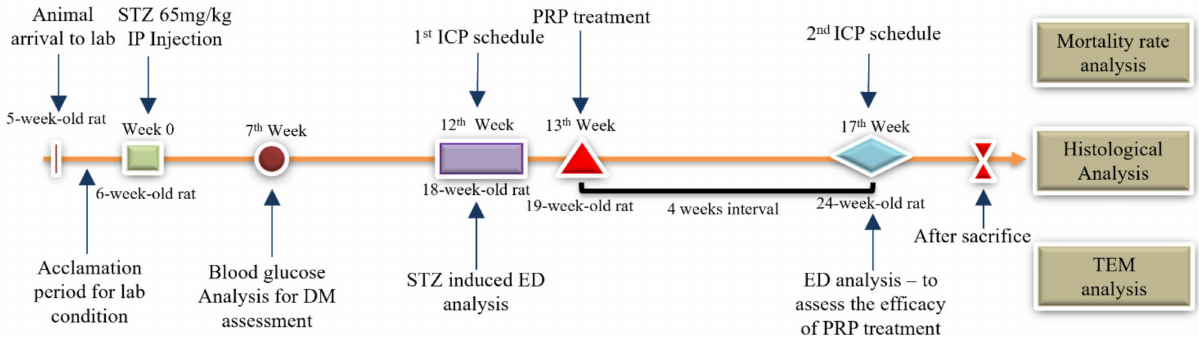
Figure 10. Timeline indicating the experimental schedule of the normal control and DM-ED rats. (TEM-transmission electron microscope; ED-erectile dysfunction; ICP-intracavernous pressure; STZ-streptozotocin; PRP-plasma rich